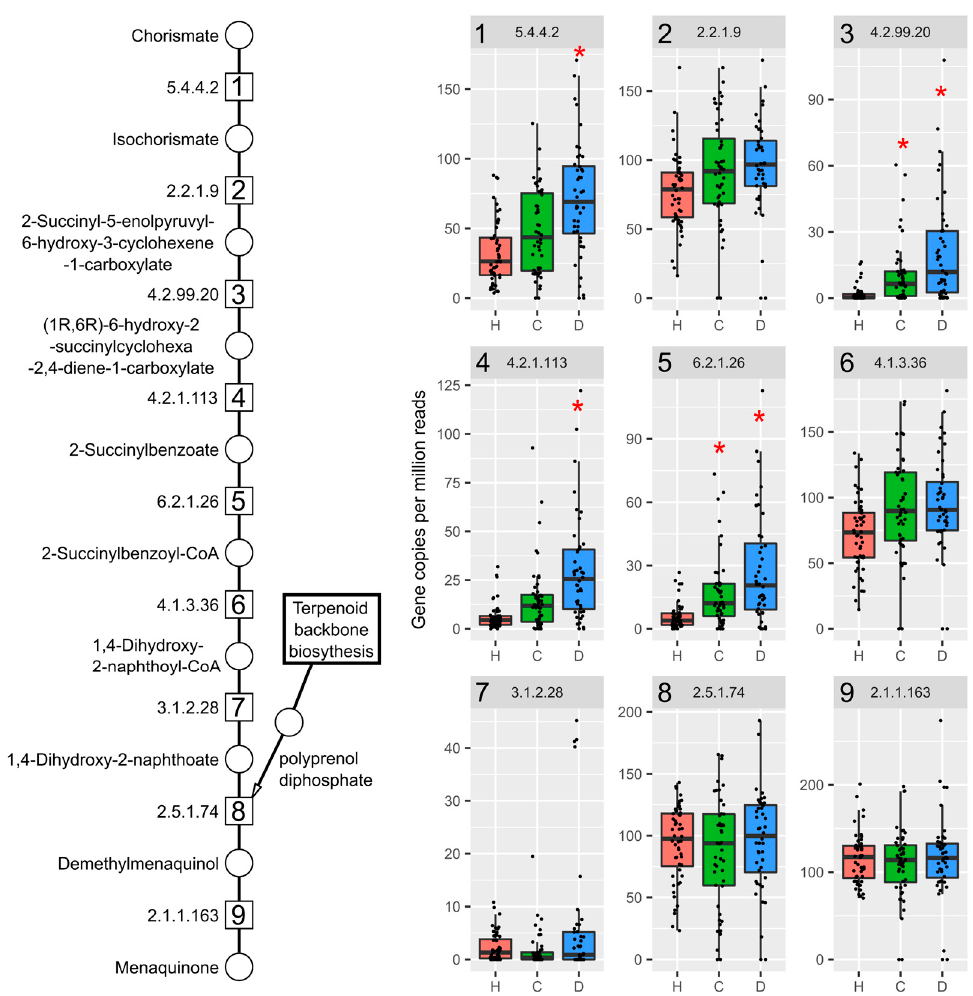
Figure 8. Menaquinone biosynthesis genes are increased in cirrhotic patients. Humann3 analysis of fecal metagenomic dataset of patients with healthy (H, red, n = 52), compensated (C, green, n = 48), or decompensated (D, blue, n = 44) liver cirrhosis diagnosis for EC numbers in menaquinone biosynthesis. Individual box plots are labeled with the EC number matching the enzymatic step in pathway schematic. Significance is denoted with a red asterisk (*; adjusted p -values < 0.05) with the healthy group as reference.